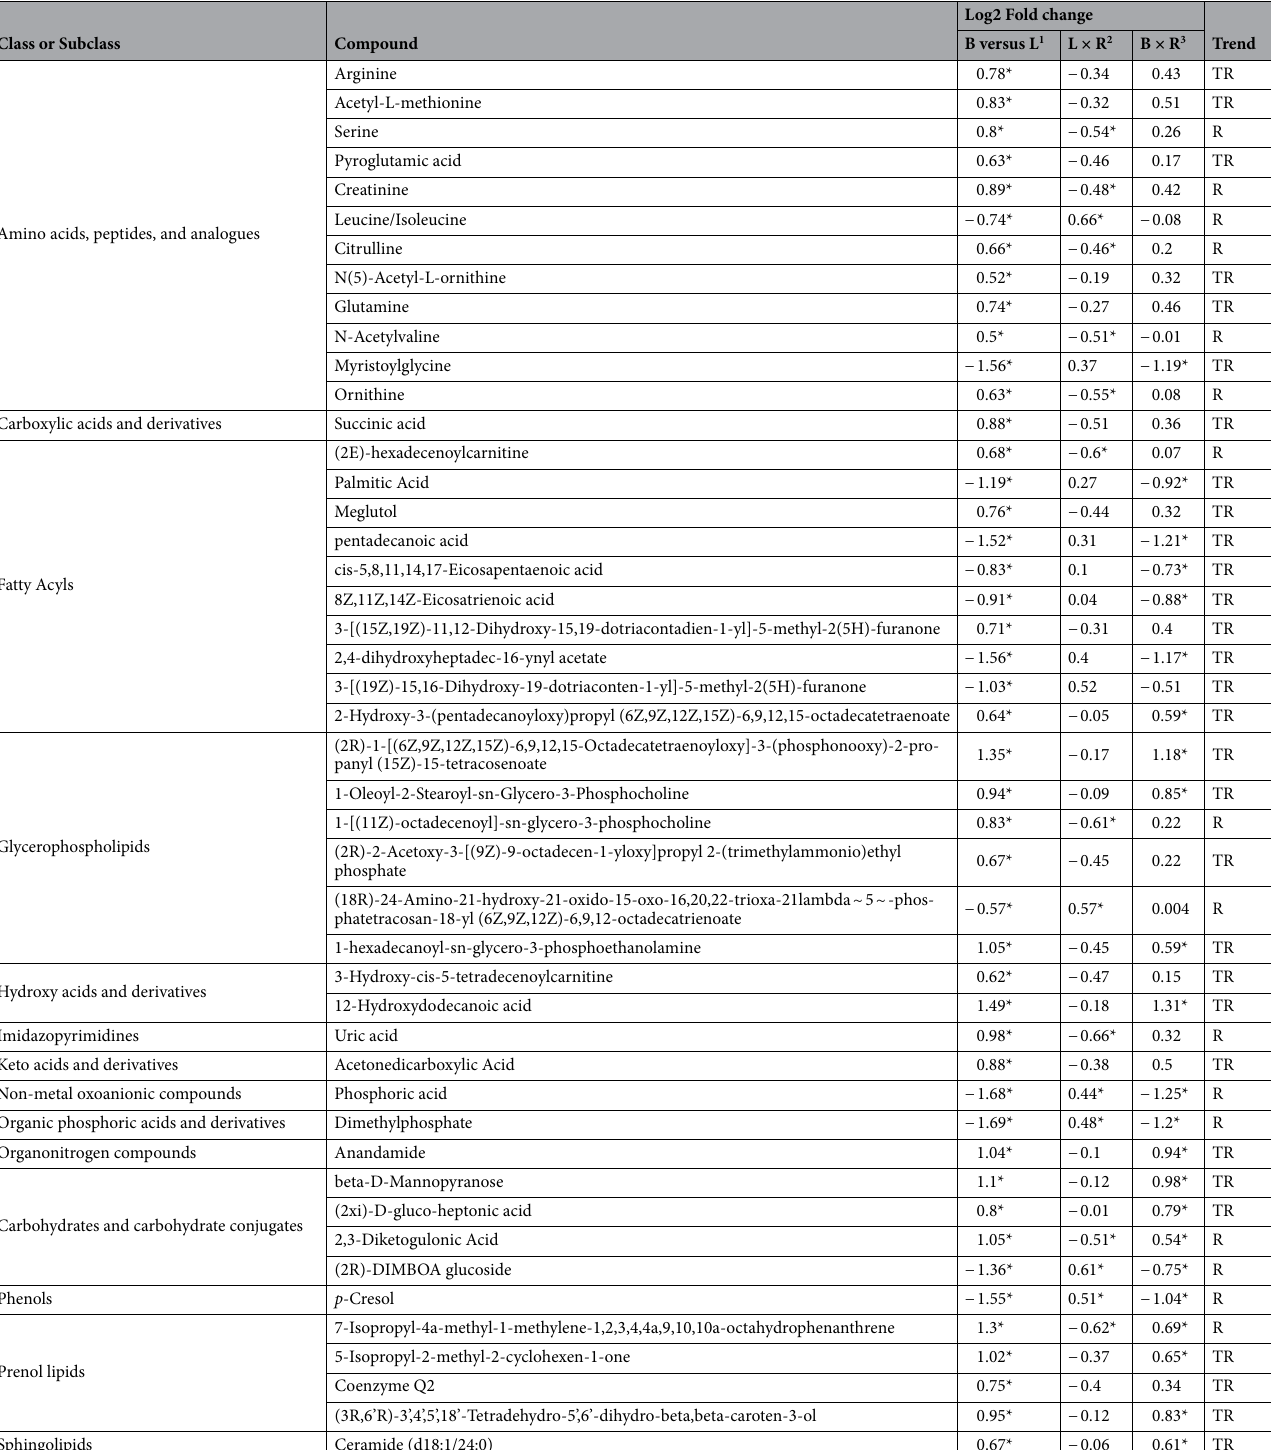
Table 2. Metabolites associated with testosterone level. Do not include putative metabolites present in Table 1. R = Recovery profile ( p -value < 0.05, Low vs. Restored)/TR = Tendency to recovery ( p value > 0.05, Low vs. Restored))/ NR = Non-restored. 2 B versus L = Basal versus Low (Basal–Low) / 3 L versus R = Low versus Restored (Low-Retored)/ 4 B versus R = Basal versus Restored (Basal – Restored) / * p value < 0.05, Pairwise comparison (Turkey Posthoc). Log2Fold Change: negative values were linked to relatively high abundant metabolites and positive values to relatively low abundant